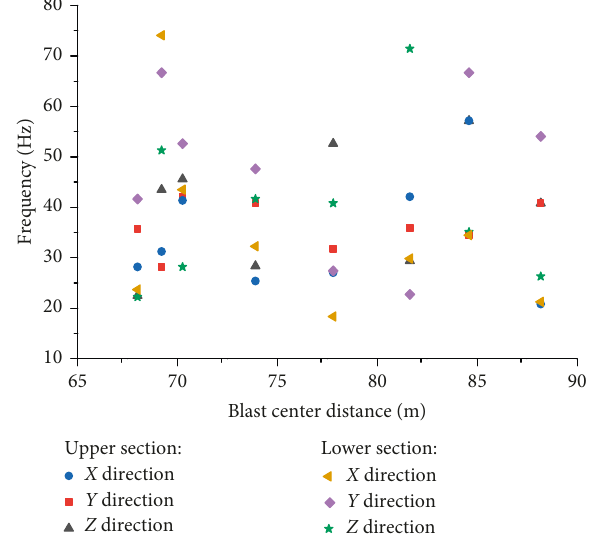
Figure 8: Distribution of the main frequency with the blast center distance of the upper and lower